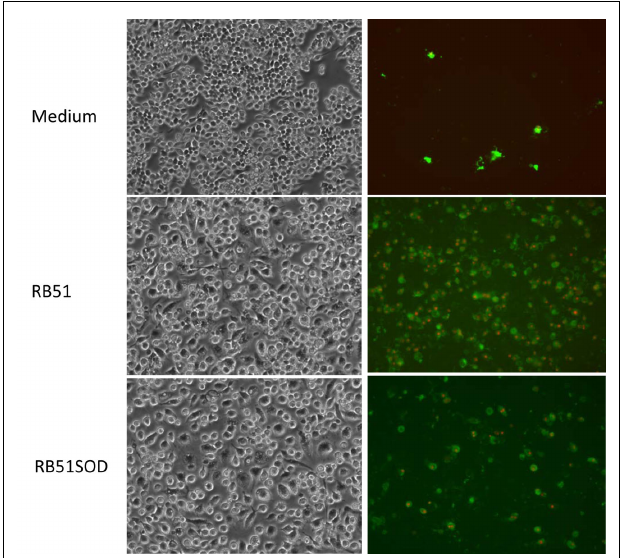
(B) Decrease in OD 600 after Brucella exposure to 0.3% SDS for increasing periods of time.The sign ∗ represents statistical significance ( P -value <